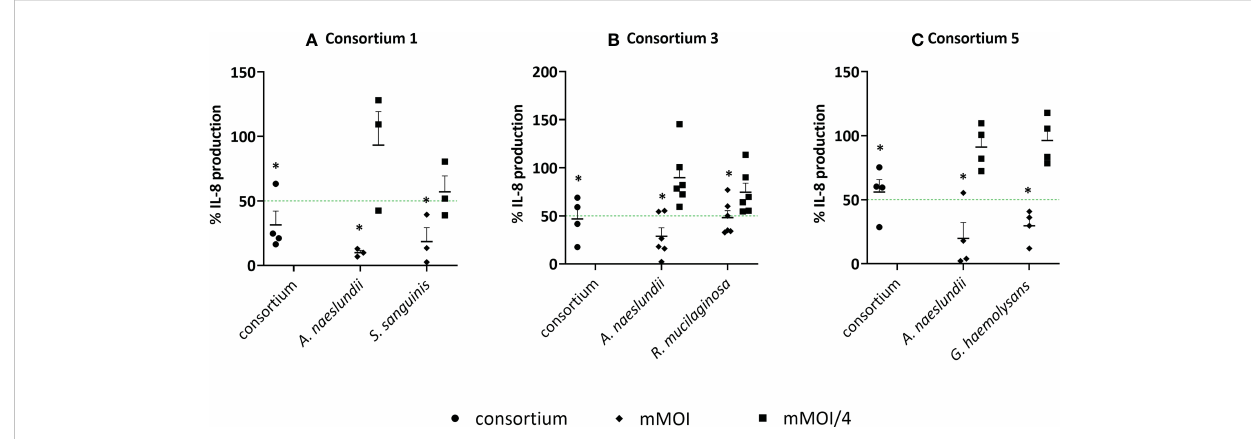
FIGURE 8 Anti-in fl ammatory activity of synergistic consortia and single species in (3D) A549 cells based on IL-8 secretion. Single species at their mMOI IL-8 and mMOI IL-8 /4 and synergistic consortia at de fi ned MOI ratios, in the presence of LPS, were evaluated for anti-in fl ammatory activity by using an ELISA for IL-8 quanti fi cation with (A) consortium 1; A. naeslundii with S. sanguinis , (B) consortium 3; A. naeslundii with R. mucilaginosa , (C) consortium 5; A. naeslundii with G. haemolysans. On the vertical axis, the % IL-8 production compared to LPS-stimulated cells is shown, on the horizontal axis the consortium and single species at selected MOI (i.e. mMOI IL-8 and mMOI IL-8 /4) are presented. Anti-in fl ammatory (synergistic) activity was de fi ned as:< 50% IL-8 production compared to LPS-stimulated cells as visualized by a green line, p< 0.05, and (FICI ≤ 0.5). *: p<0.05, n ≥